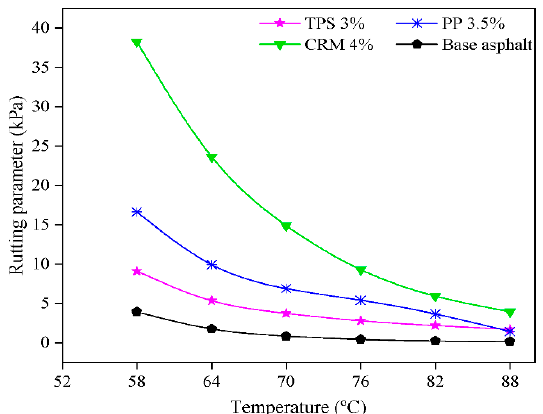
Figure 6. G* / sin( δ ); temperature curves of modified and unmodified asphalt Figure 6. G*/sin( δ ); temperature curves of modified and unmodified asphalt binders.